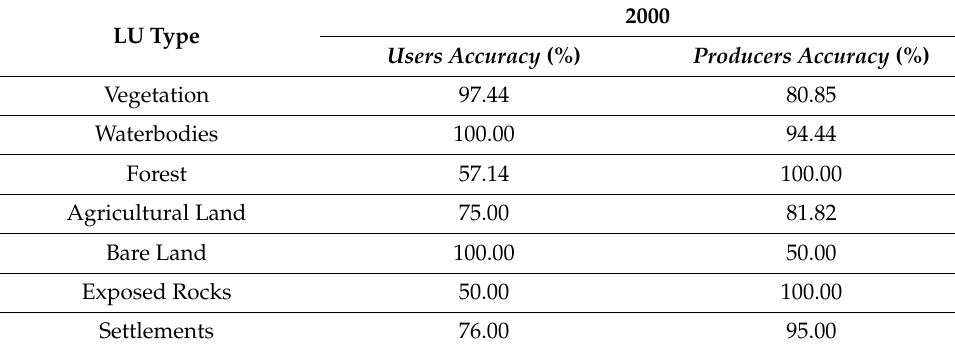
Table A5. User accuracy and overall accuracy for the LU/LC types in 2000.